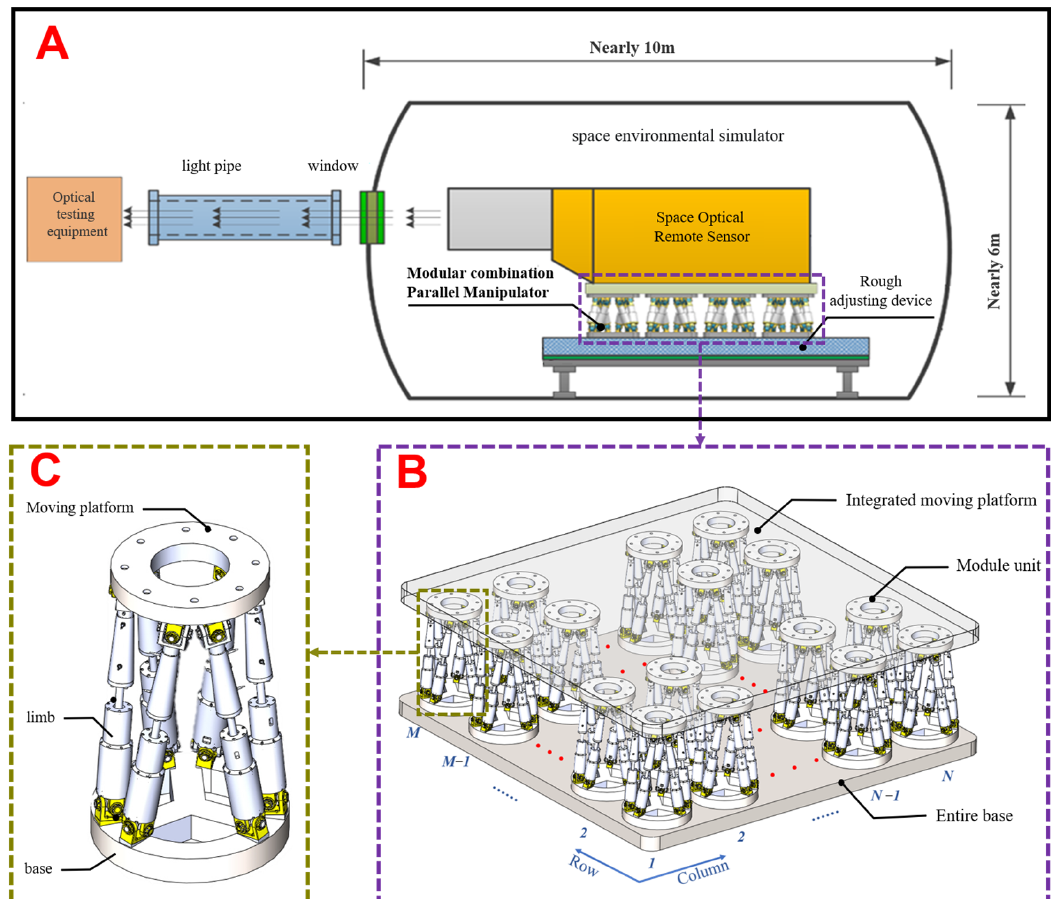
Figure 1. Schematic of ( A ) application scenario, ( B ) modular combination parallel manipulator (MCPM), and ( C ) module unit.